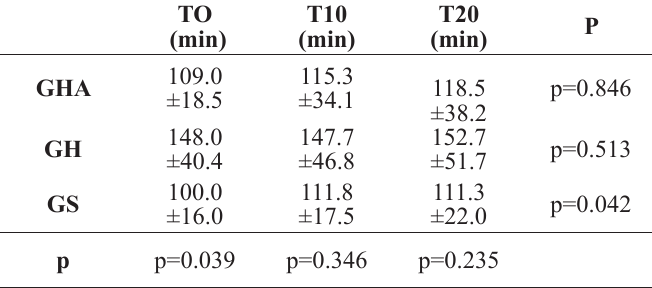
TABLE 4 - Distribution (means and standard